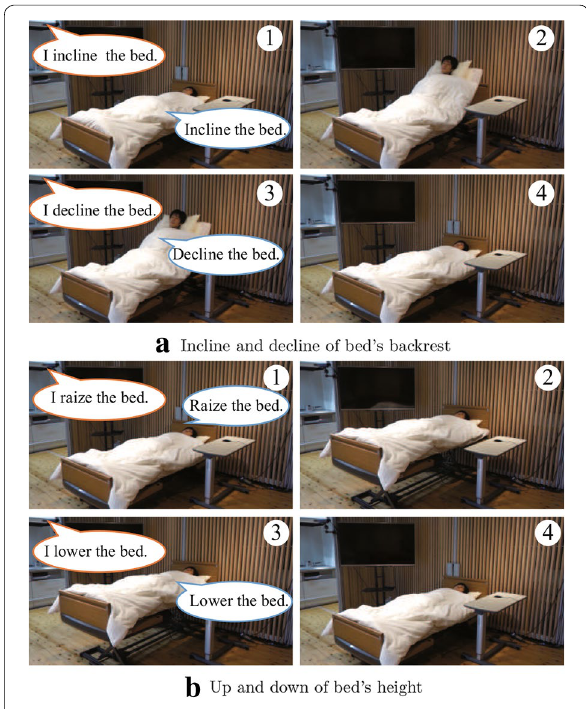
Fig. 14 Bed control by voice